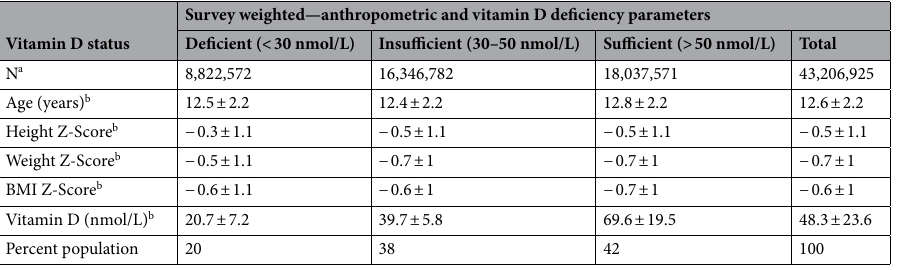
Table 2. Survey Weighted parameters (age, anthropometric Z scores and Vitamin D concentrations and prevalence of deficiency/insufficiency and sufficiency) of the study population as per vit D deficiency category (n = 2500, all values survey-weighted). a Survey weighted descriptive as per Indian population Census 2011 21 . b All the groups were significantly different from each other, p < 0.05.